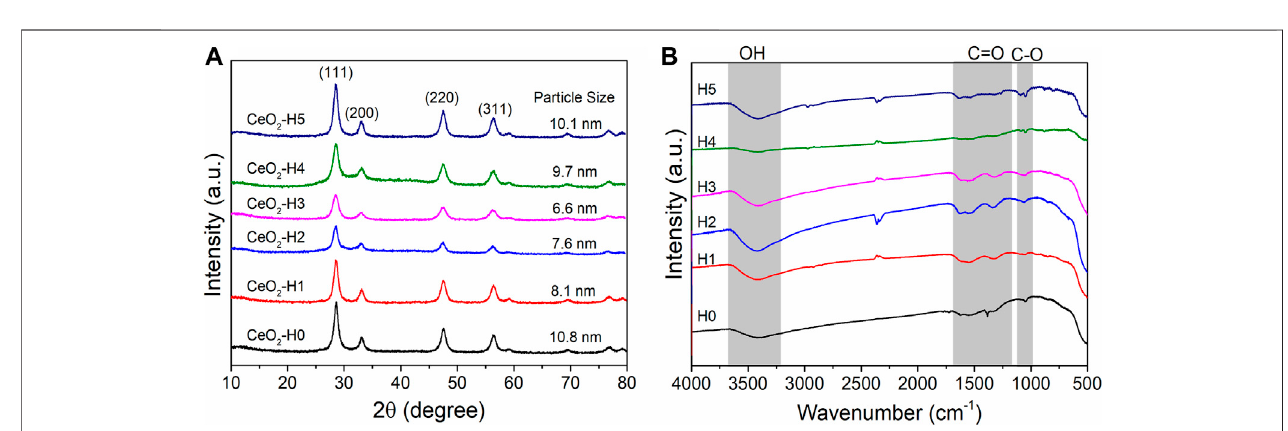
FIGURE 2 | XRD (A) and IR (B) spectra of CeO 2 by the combined microwave – ultrasonic method and calcined at 500 ° C in air for 1 h. The particle sizes in (A) are calculated by Scherrer equations based on the strongest peak at 28.5 ° .